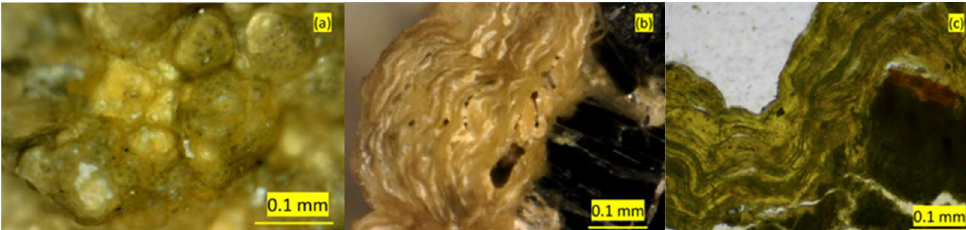
Figure 4. Micrographs of Stefføya samples: ( a ) surface of mineral crust showing botryoidal formations, ( b ) cross-section of botryoids showing laminated crust structure on the parent rock (black in color), and ( c ) polished thin section with lamina.